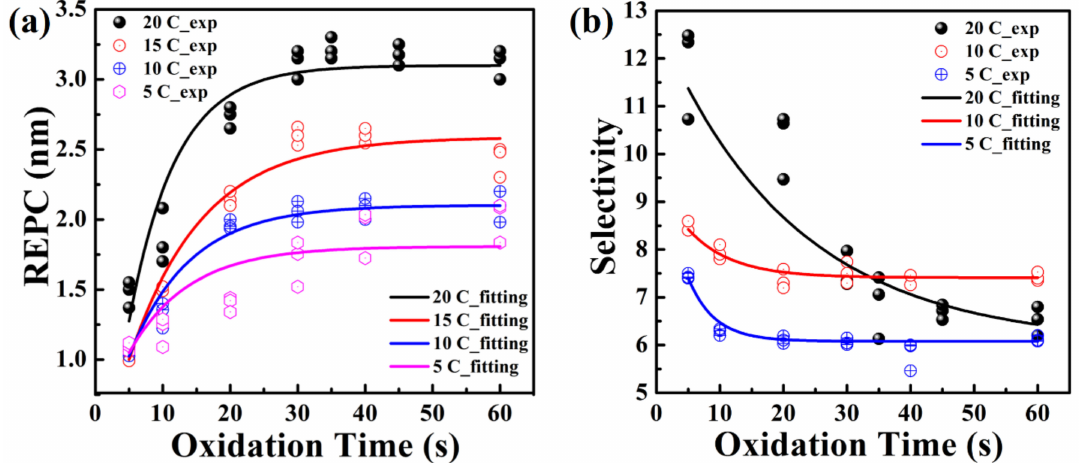
Figure 6. ( a ) The REPC of p + -Ge 0.8 Si 0.2 /Ge at different HNO 3 temperatures (20 ◦ C, 15 ◦ C, 10 ◦ C, 5 ◦ C) as a function of oxidation time. ( b ) The selectivity between p + -Ge 0.8 Si 0.2 and Ge at different HNO 3 temperatures (20 ◦ C, 10 ◦ C, and 5 ◦ C) as a function of oxidation time. The scatters and solid lines represent the experimental data and fitting curves of the experimental